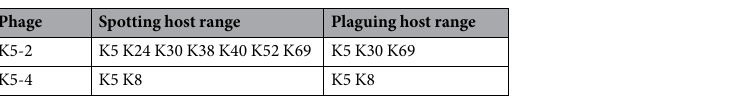
Table 1. Host range of phages K5-2 and